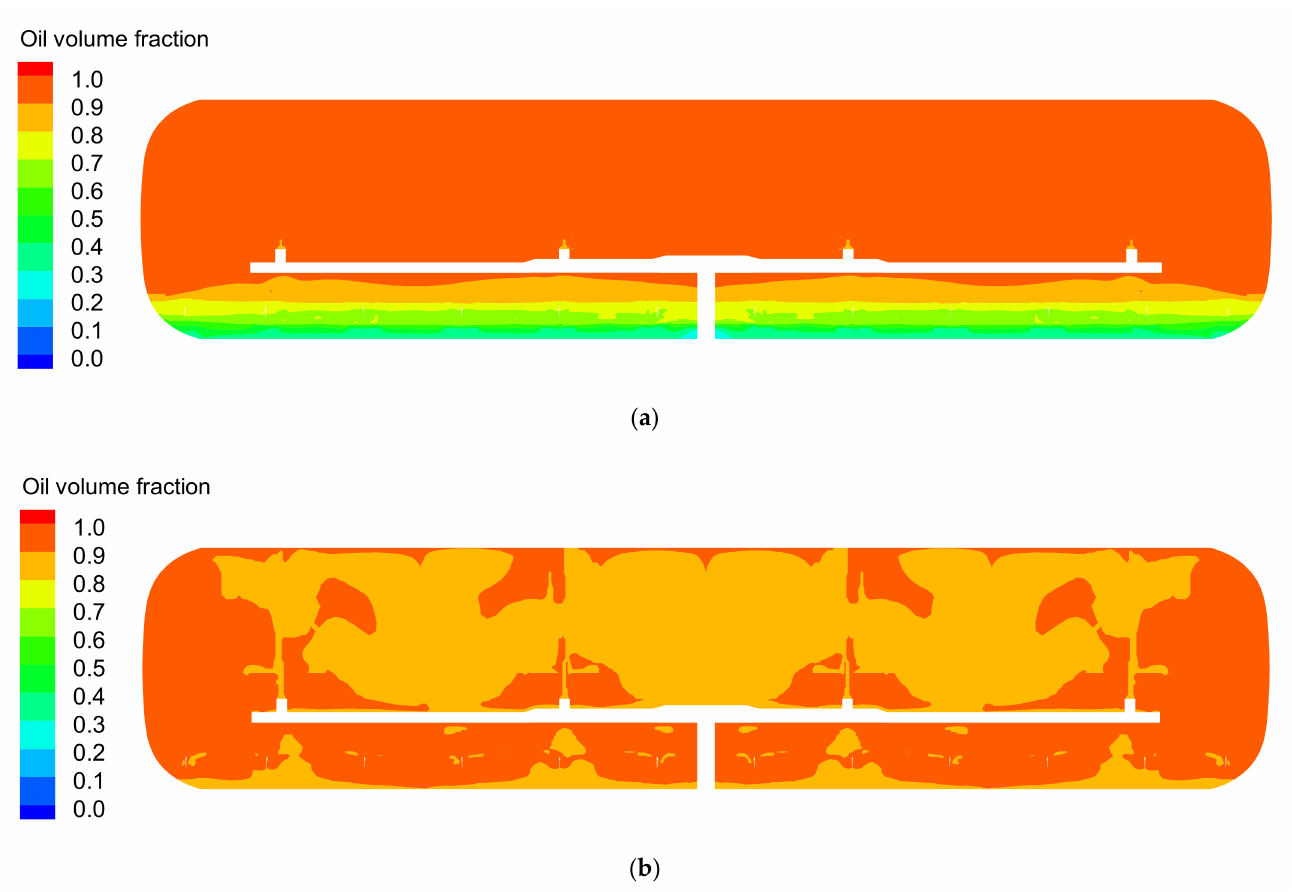
Figure 8. Oil volume fraction for ( a ) with a constant electric field of 1 kV/cm and ( b ) without an electric field. The remaining variables and properties correspond to the standard conditions (see Table